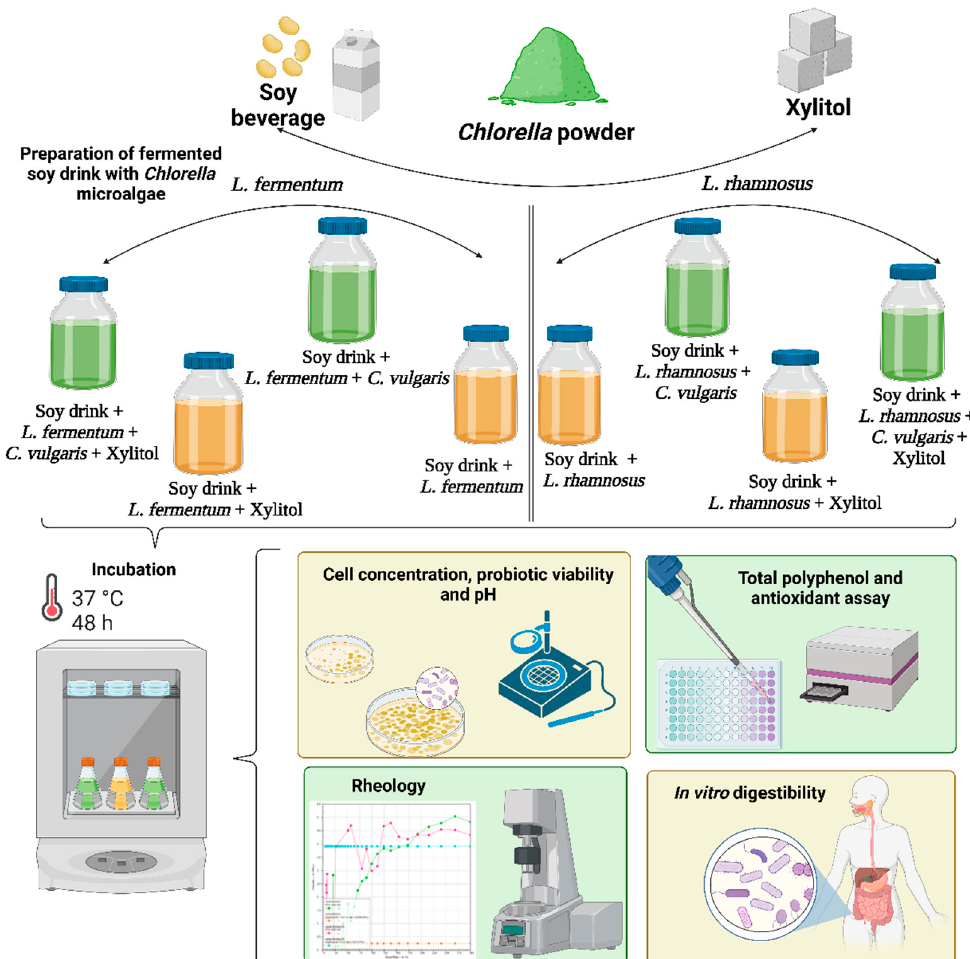
Figure 1. Schematic representation of the experimental design: 1. Preparation of fermented soy drink with C. vulgaris microalgae; 2. Determination of cell concentration; 3. Rheological measurements; 4. Determination of total polyphenols and antioxidant activity; 5. In vitro simulation of gastrointestinal food digestion .